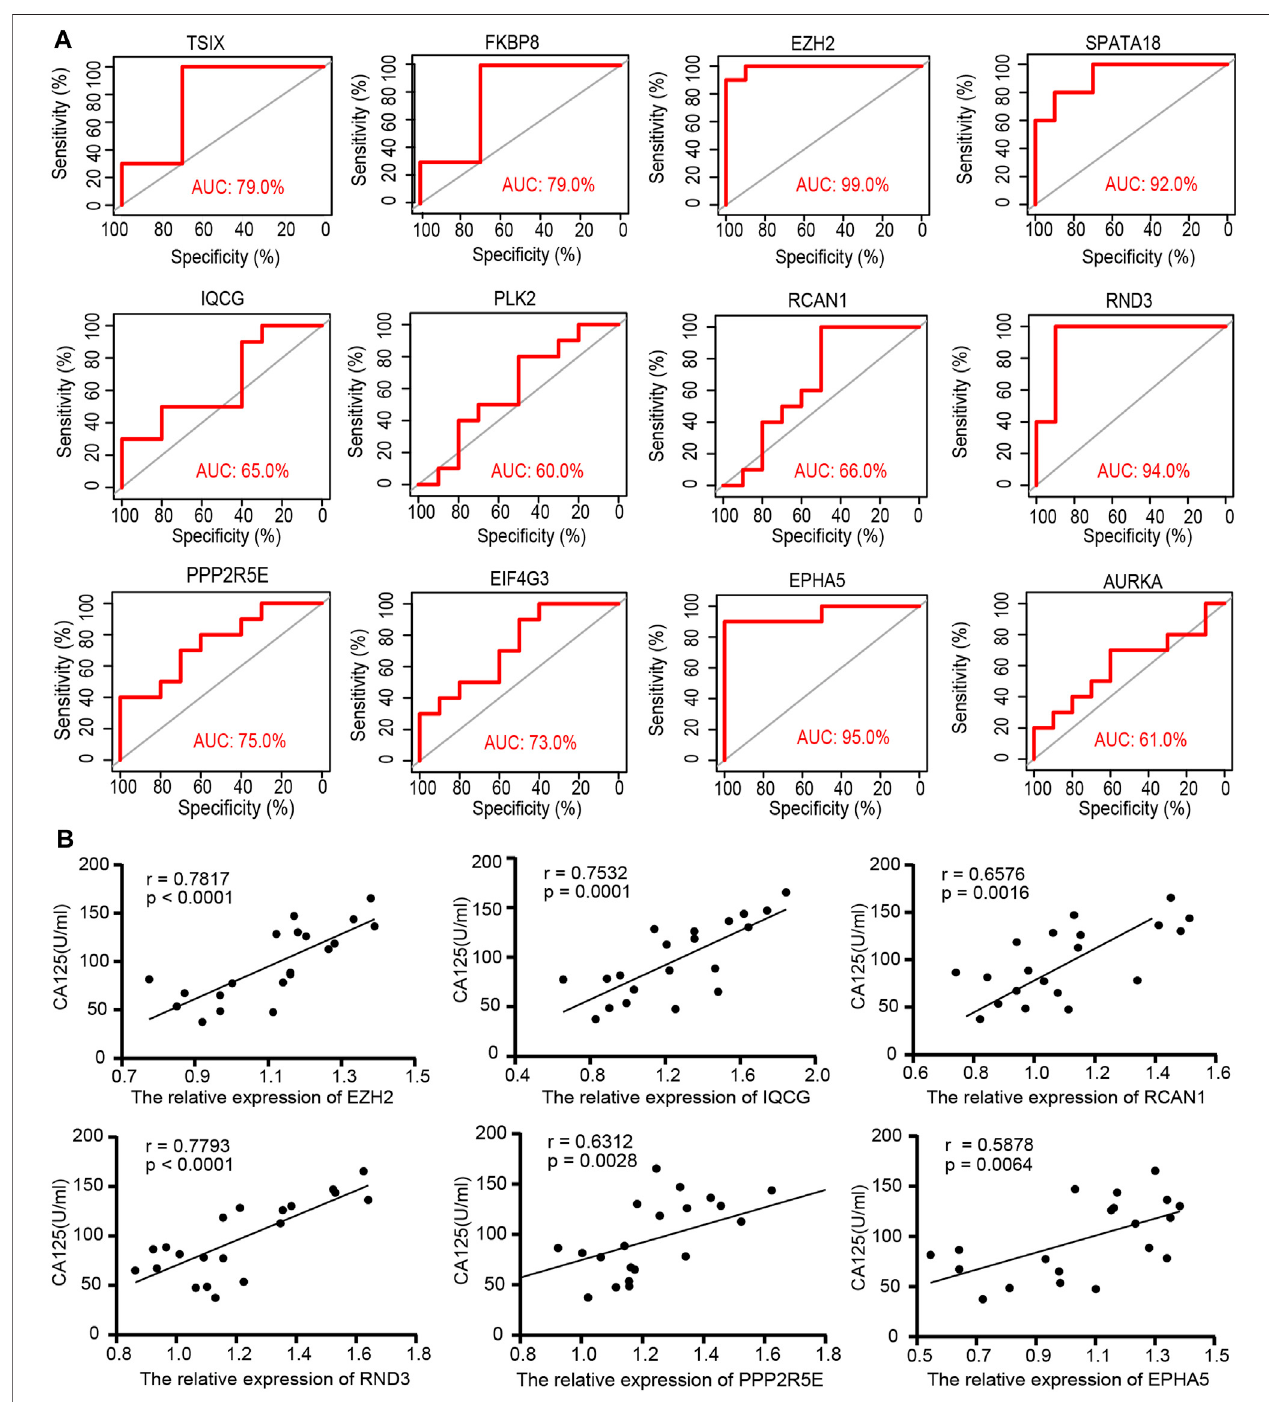
FIGURE 6 | The speci fi city and sensitivity of the 12 hub ATGs for the diagnosis of endometriosis by the receiver operating characteristic (ROC) analysis (A) . The relative expression of the 6 hub ATGs in tissues were positively correlated with Ca125 by Spearman correlation analysis (B) .